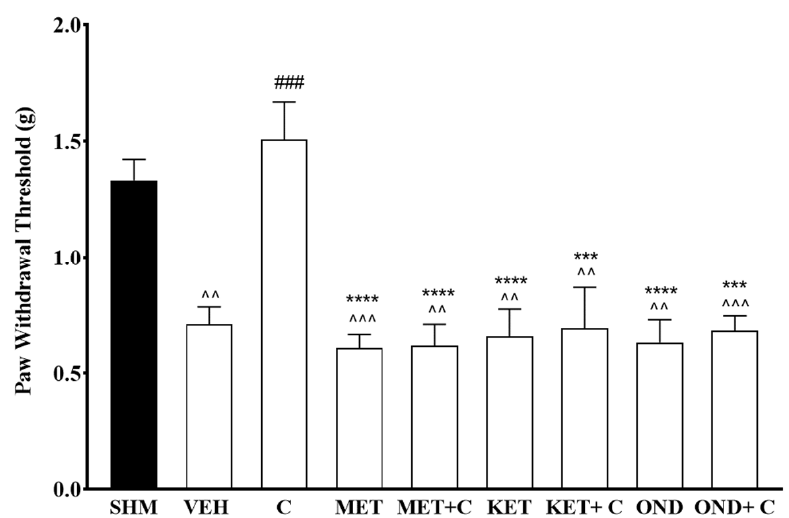
Figure 3. Effect of methiothepin (5-HT1/6/7 receptor antagonist), ketanserin (5-HT2A receptor an- tagonist), and ondansetron (5-HT3 receptor antagonist) pre-treatment on cardamonin against thermal hyperalgesia of CCI-induced neuropathic pain mice were evaluated using Hargreaves’ Plantar test. Data were presented as mean ± SEM ( n = 6). The caret, hash, and asterisks denote the significance levels (one-way ANOVA, followed by Tukey’s post hoc test, ˆˆˆˆ p < 0.0001 as compared to sham, #### p < 0.0001 as compared to vehicle and **** p < 0.0001 as compared to cardamonin-treated group. SHM (Sham); VEH (Vehicle, 10 mL/kg i.p.); C (Cardamonin, 10 mg/kg i.p.); MET (Methiothepin, 0.1 mg/kg, i.p.); KET (Ketanserin, 0.3 mg/kg, i.p.); OND (Ondansetron, 0.5 mg/kg, i.p.).